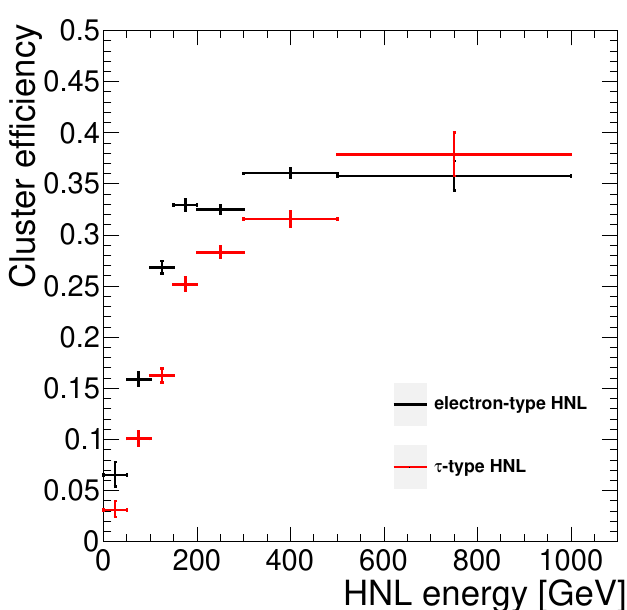
Figure 1 . The reconstruction efficiencies of CSC cluster estimated by the CSCClusterEfficiency module as a function of the HNL energy are shown for electron- and τ -type HNL decays. The HNLs have masses of 3 GeV and cτ of 1